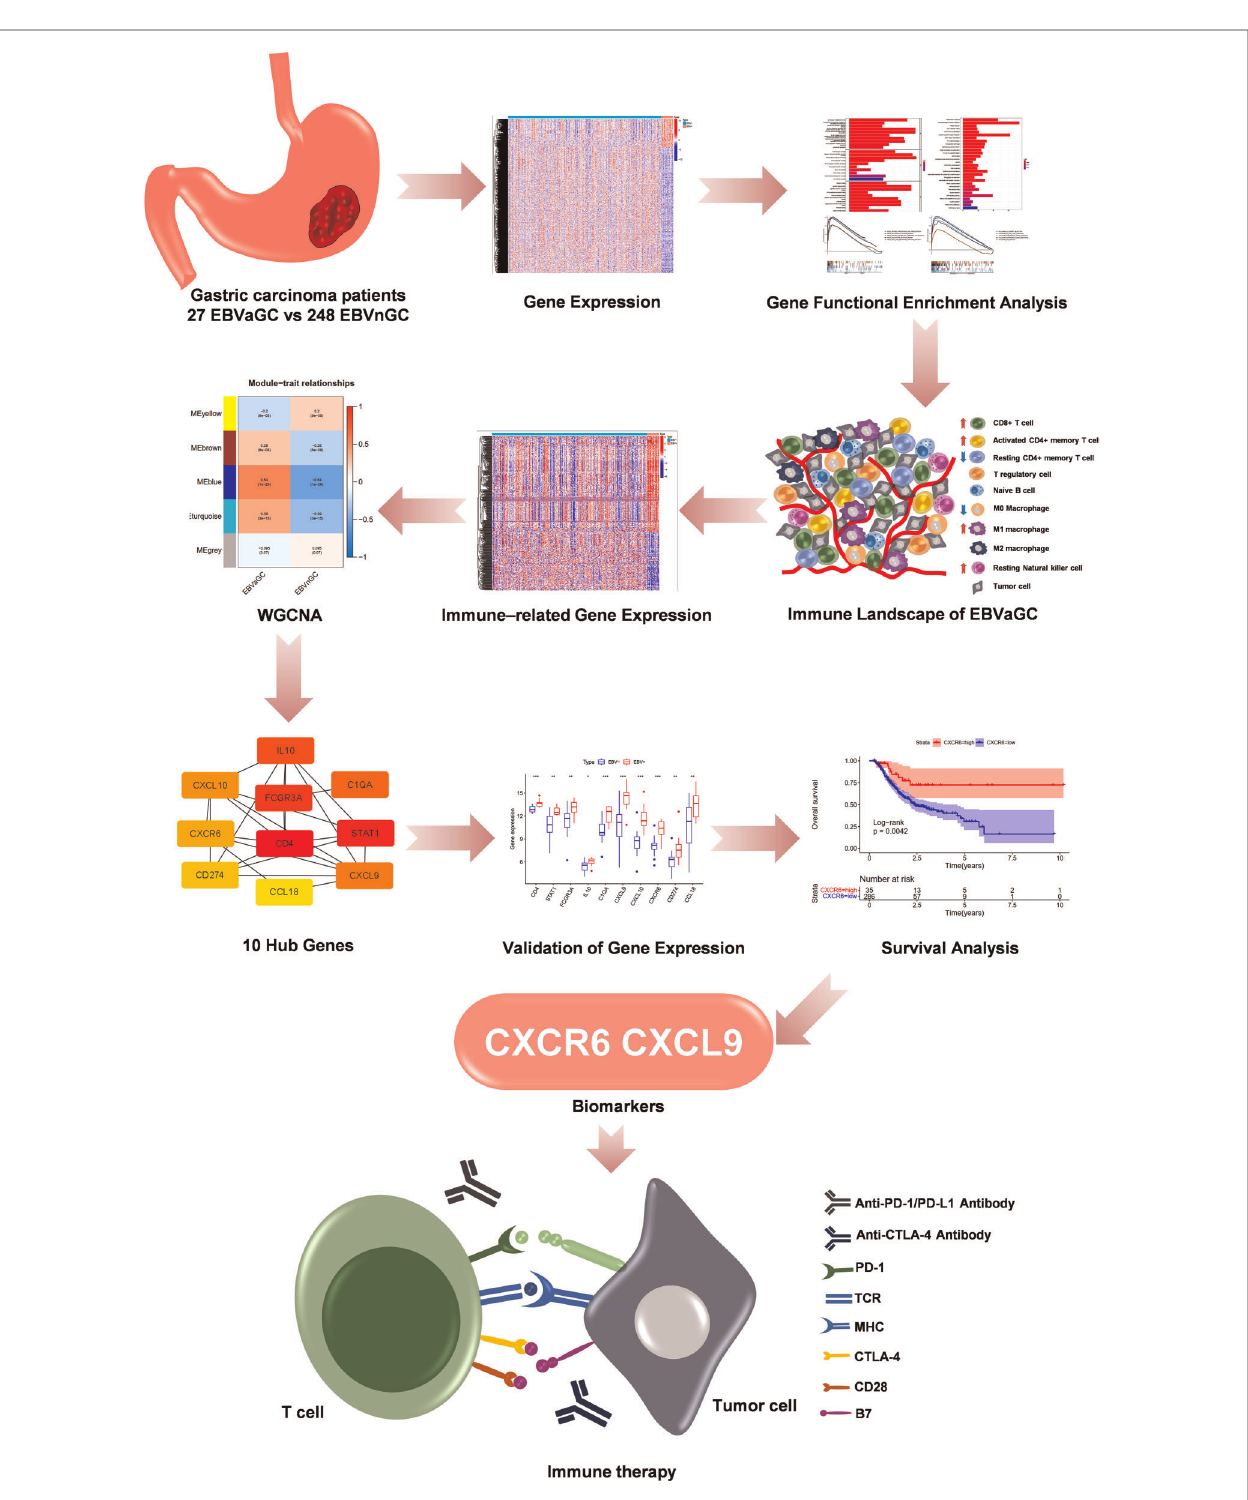
FIGURE 1 | The fl ow diagram and analysis methods of our